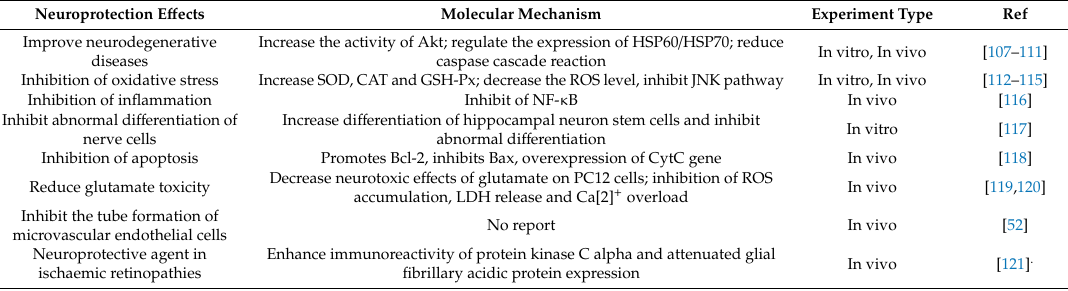
Table 6. Neuroprotective e ff ects and mechanisms of LBPs.